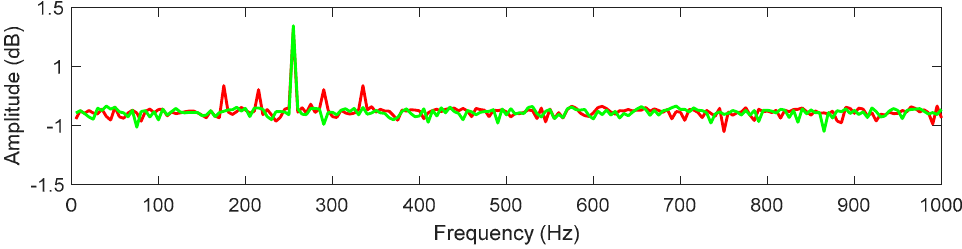
Figure 8. Original signal with noise using FFT.